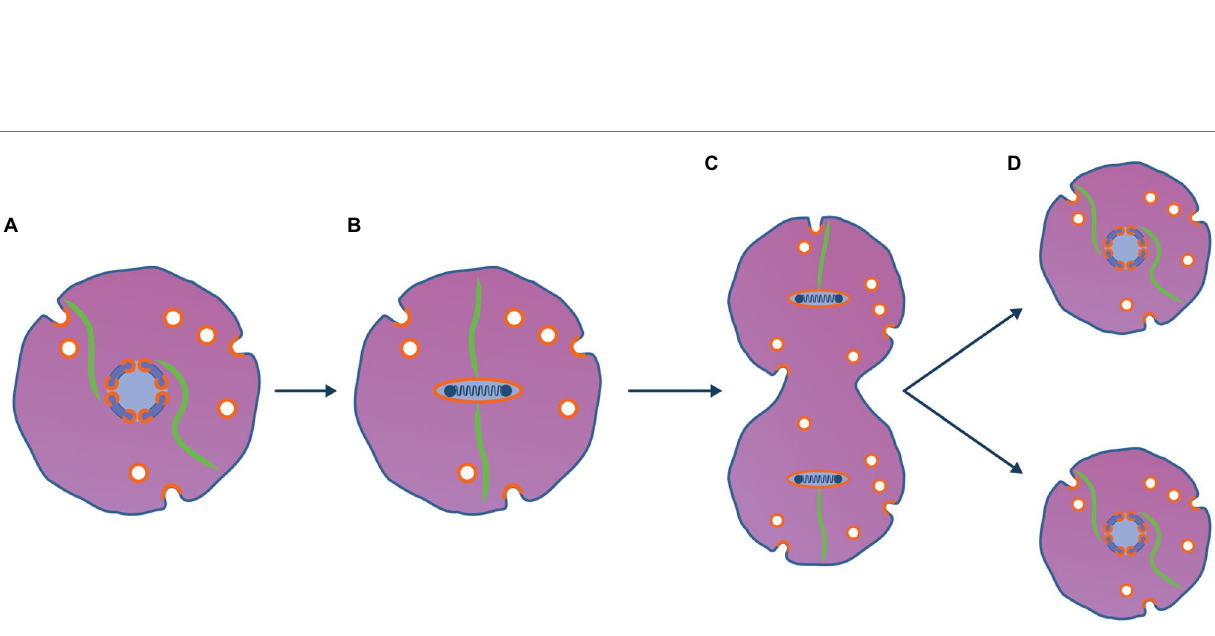
FIGURE 3 | Viral method to partition viral chromosome to daughter cells is ancestral to mitosis. (A) A copy number control mechanism based on centromeres and partitioning proteins analogous to those seen with phage and plasmids maintains the viral genome as a single copy [(1 N); Ebersbach and Gerdes, 2005]. (B) Prior to the archaeal host entering a cell division, the viral genome is replicated (becomes 2 N) and is condensed using the viral nucleosomes used to package the genome into virions. When the 2 N genome is condensed, viral transcription and translation cease and the tubulin cytoskeleton binds to the viral genome at the centromere. (C) Prior to binary fission using typical archaeal mechanisms, the virus encoded dynamic tubulin proteins bind to centromeric sequences of the viral genome pulling the genome to opposite poles of the cell. (D) After the cell has divided the viruses re-establish 1 N viral factories and resume transcription and